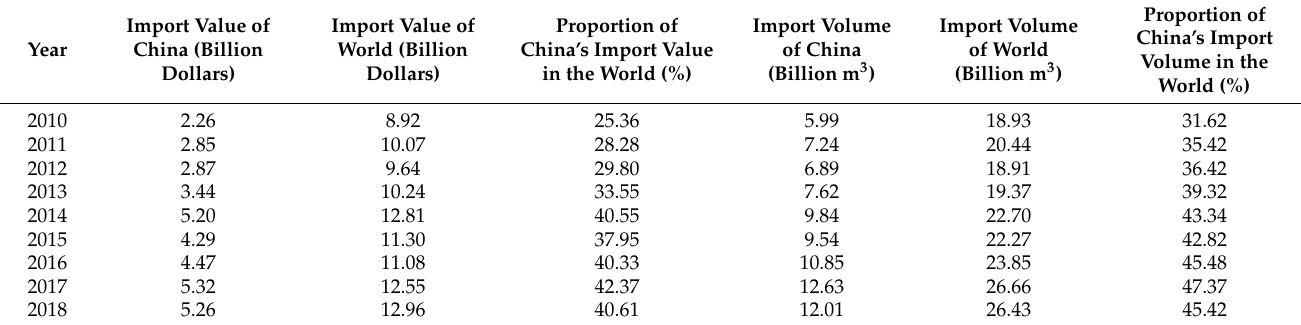
Table 1. China’s hardwood lumber imports from 2010 to